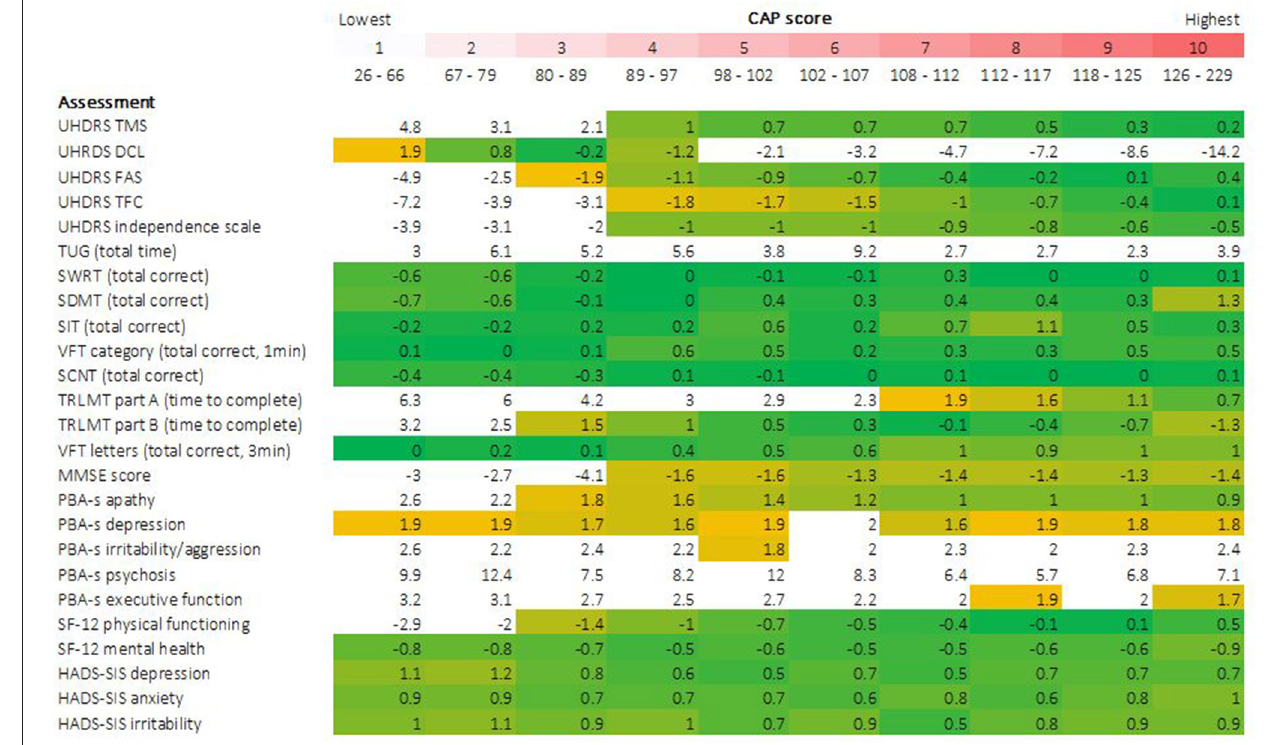
FIGURE 2 | Skewness of clinical assessment data by CAP score. Degree of data skewness observed within each CAP score decile is illustrated for each clinical outcome. Cells are color coded conditional on observed skewness statistic. A threshold of ± 2, indicating extreme positive or negative skew, was defined a priori to identify extreme skew, indicative of floor/ceiling effects. Cells with values more extreme than these thresholds are colored white. All remaining cells, with skewness statistics ranging from − 2 to + 2, are color coded on a yellow-green-yellow gradient, centered at 0 (green), indicative of a perfect normal distribution of data, graduating to yellow as values become more